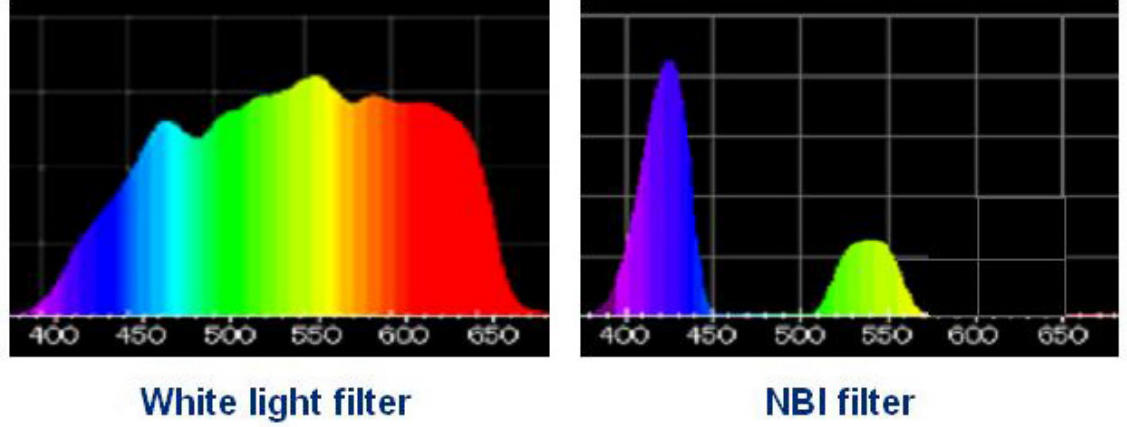
FIGURE 1. Reproduction of the radiance of the spectrum obtained when using the broadband (white light) interference filter in the range 400 to 650 nm, or the narrowband (NBI light) interference filter, with 2 distinct peaks, blue at 415 nm and green at 540 nm. Note the higher radiance of the blue band. (courtesy of Olympus Corporation, Japan).